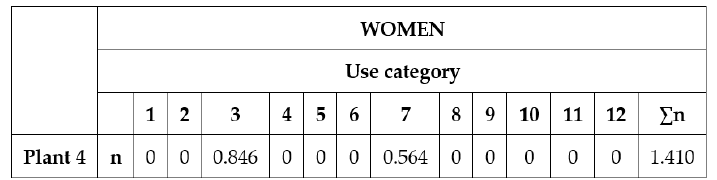
Figure 3. Example data from Table 1 (paper card) transcribed to a spreadsheet structure (first row of Figure 2).